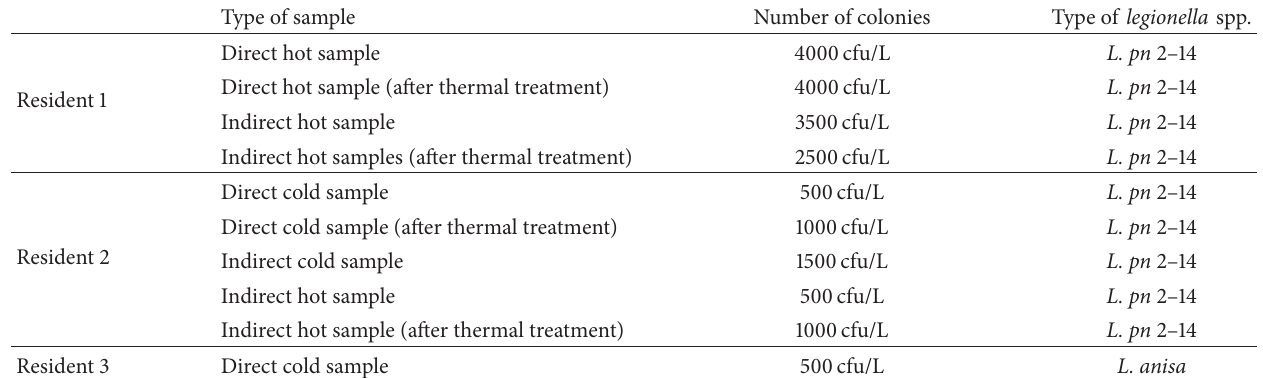
Table 5: Results of the culture for Legionella